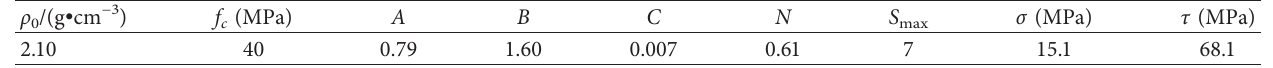
Table 2: Conductive parameters for the concrete.